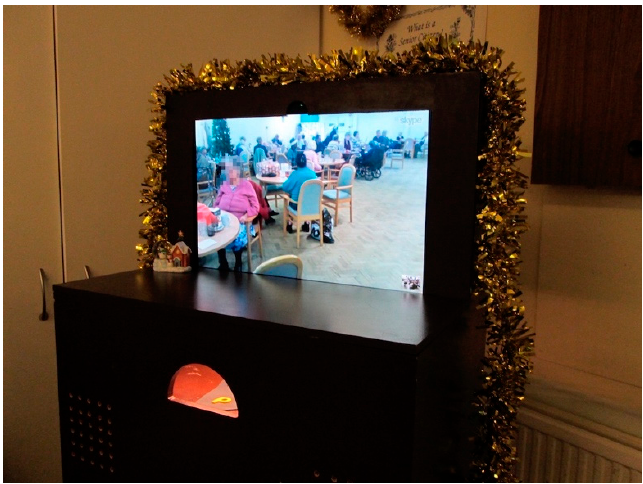
Figure 4. TT kiosk at day centre 2. The TT kiosk shows a view into day centre 1. Permission granted by Dr Marianne Markowski. Dr Marianne